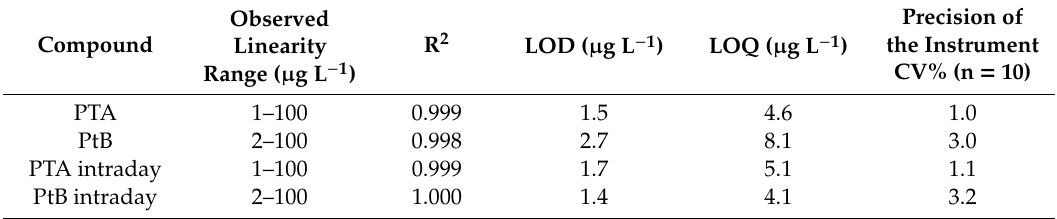
Table 4. Validation of the LC-MS method for PTA and PtB determination (preservation and SPE method development) [43].